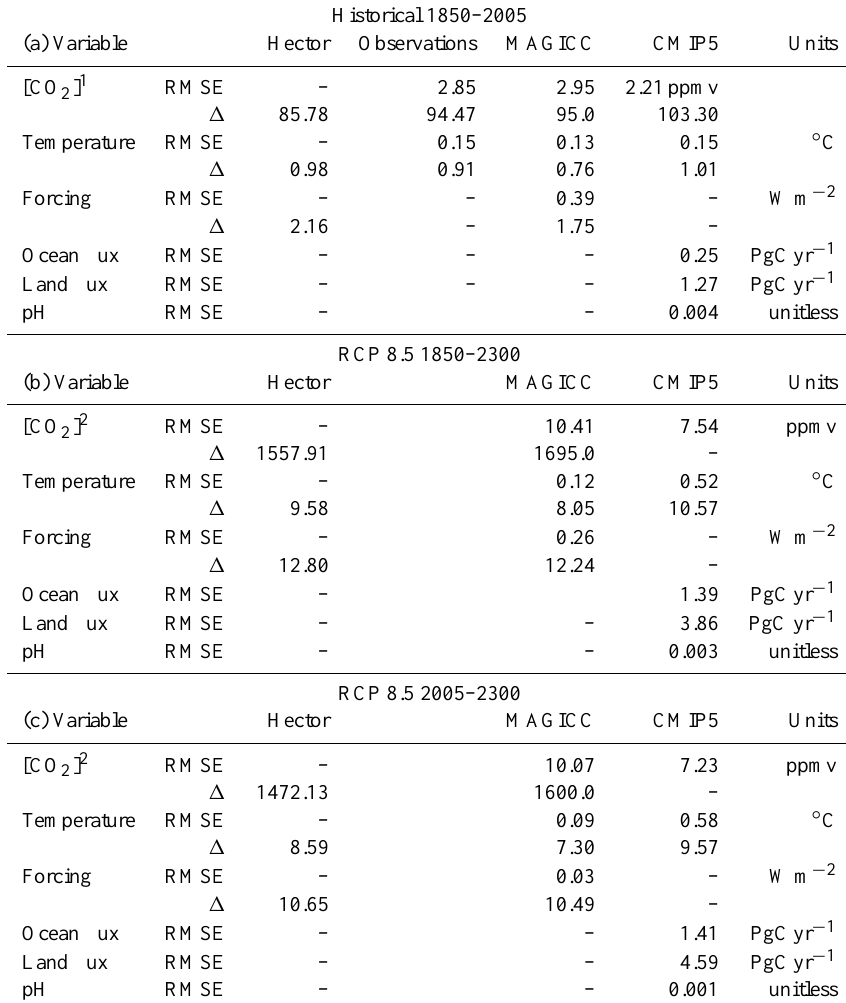
Table 4. Root mean square error (RMSE) for Hector versus observations, CMIP5, and MAGICC for atmospheric [CO 2 ], surface temperature anomaly, radiative forcing, fluxes of carbon (ocean and land), and low-latitude surface ocean pH and change ( (cid:49)) in atmospheric [CO 2 ], surface temperature anomaly and radiative forcing for Hector, CMIP5, observations, and